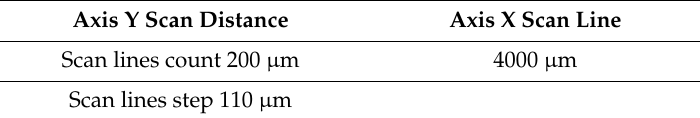
Table 6. LPM setting parameters for sample